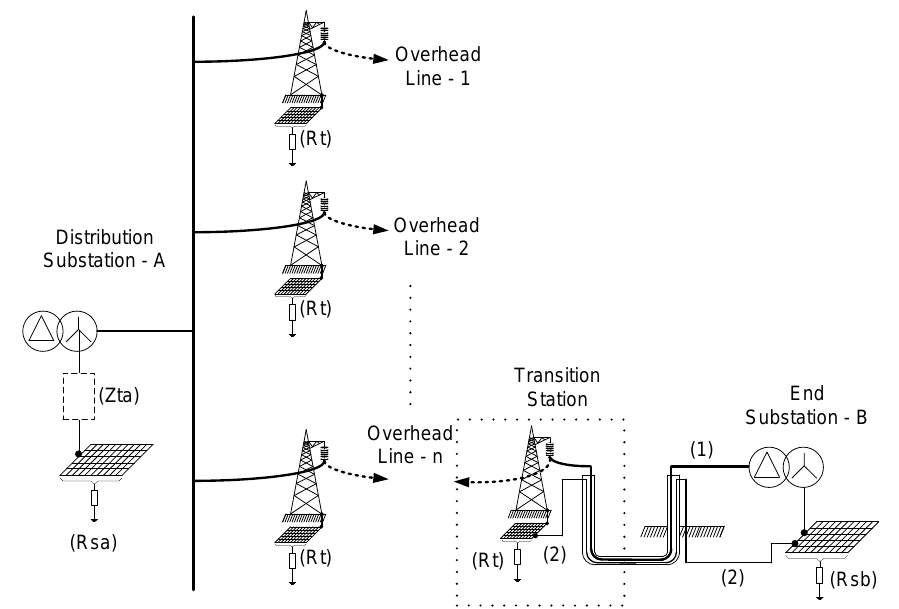
Figure 1. Power distribution network with transition cable-overhead line. (1) Active conductor of power cables; (2) Shields of the power cable; (R t ) Tower ground resistance; (R sa ) Ground resistance of distribution substation-A; (R sb ) Ground resistance of end substation-B; (Z ta ) Grounding impedance.